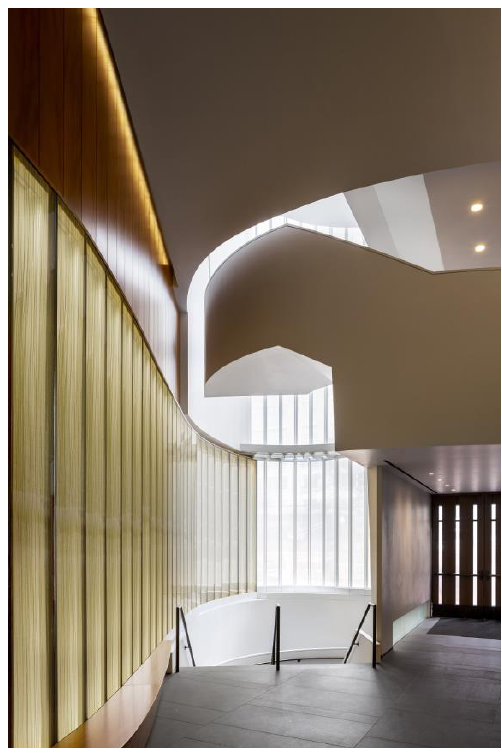
Figure 6. Entrance doors (right). Stairs (center) down to multi-functional room. View to east with part of curving façade. Photo David Sundberg/ESTO. Ahead, a large window at the far (west) end offers a view of daylight and nature (Figures 4 and 7).